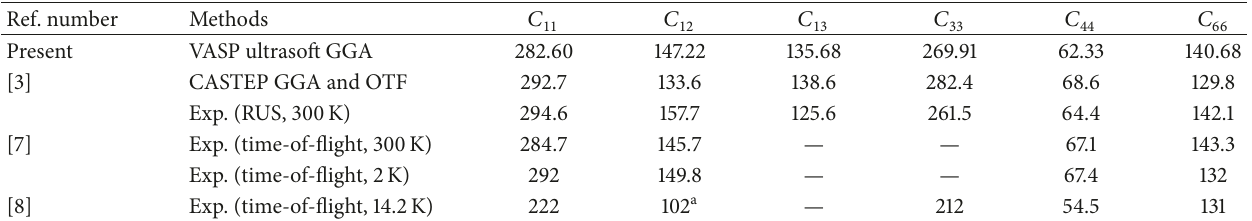
Table 3: Second-order elastic constants 𝐶 𝑖𝑗 (GPa) of tetragonal YNi 2 B 2 C at 0 K and 0GPa, in comparison with the previous calculations and available experimental measurements.